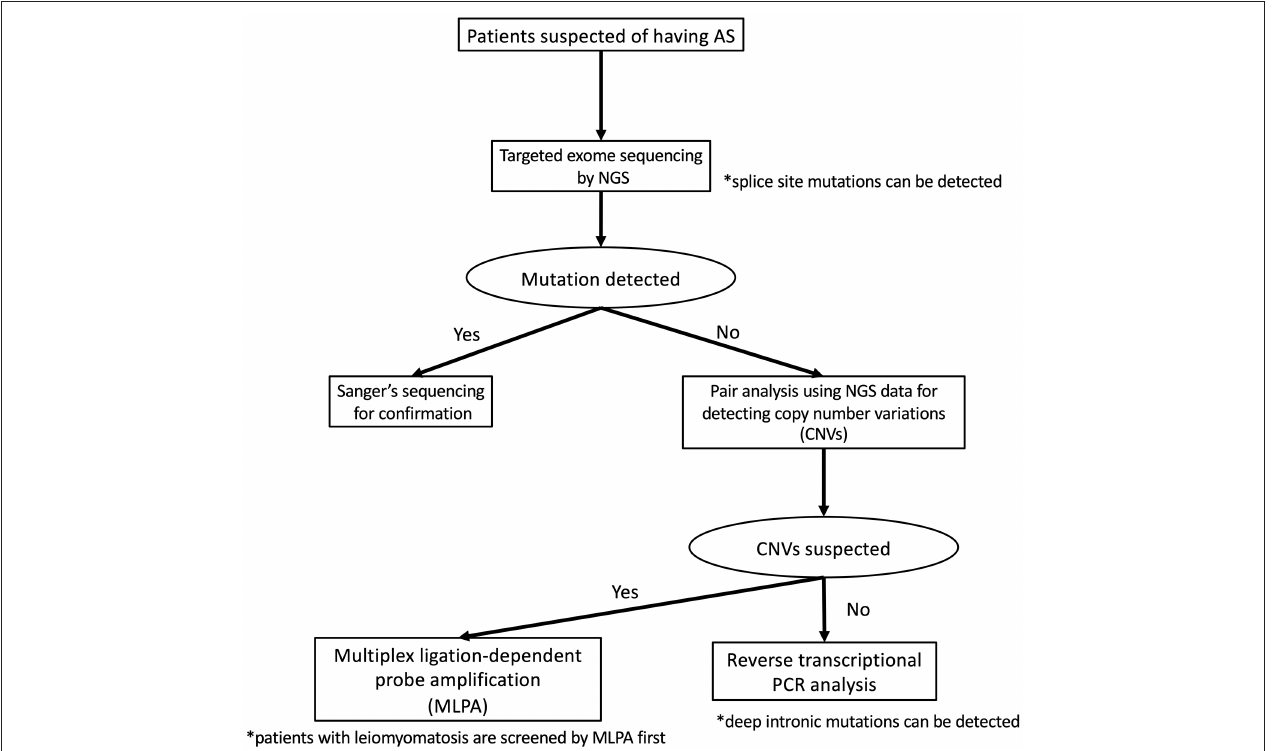
FIGURE 2 | Mutational analysis approach for patients suspected as having Alport syndrome in our laboratory. In our laboratory, patients suspected as having Alport syndrome are first screened targeted exome sequencing by using NGS. If this first screening does not detect any pathogenic variants, screening for copy number variations (CNVs) in the COL4A4/COL4A4/COL4A5 genes is performed using paired analysis. When paired analysis detects the possibility of CNVs in cases, multiplex ligation-dependent probe amplification (MLPA) is used to confirm. In addition, for patients with no obvious pathogenic variants, RNA sequencing using reverse transcription PCR is